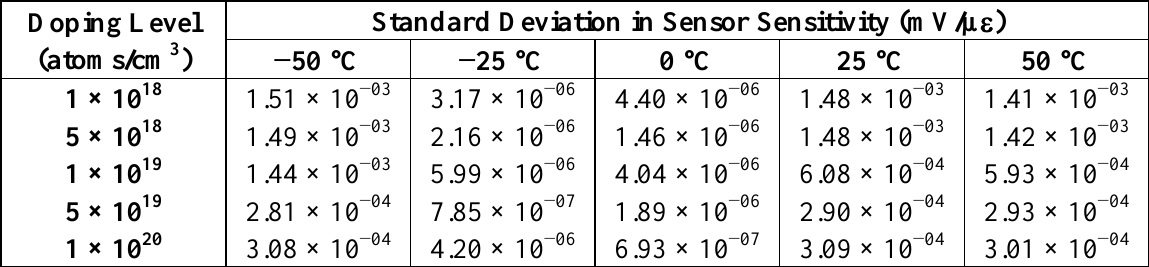
Table 3. Standard deviation of the calculated sensor sensitivity at different operating temperatures depicted from Figure